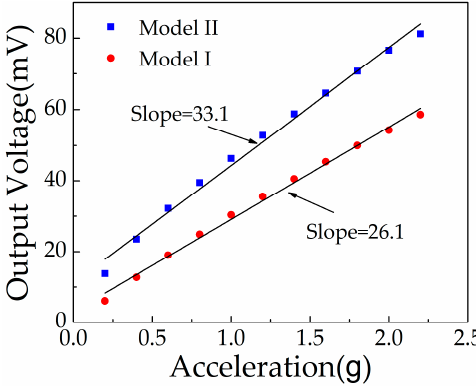
Figure 13. Output voltage of sensor working in model I and model II.